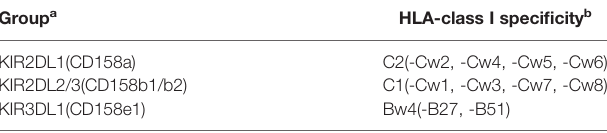
TABLE 2 | Three subfamilies of KIRs and speci fi c ligands. Group